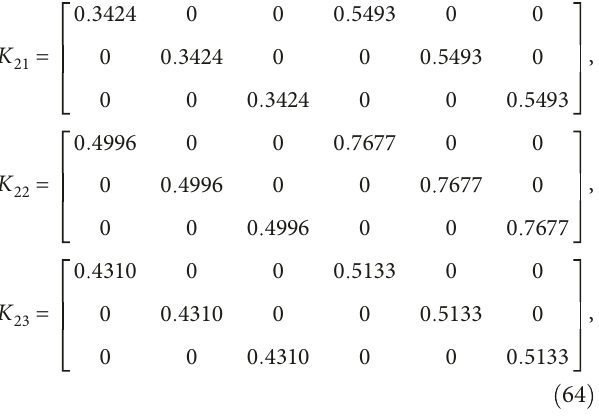
Figure 6: State trajectories of ε T t R ε t